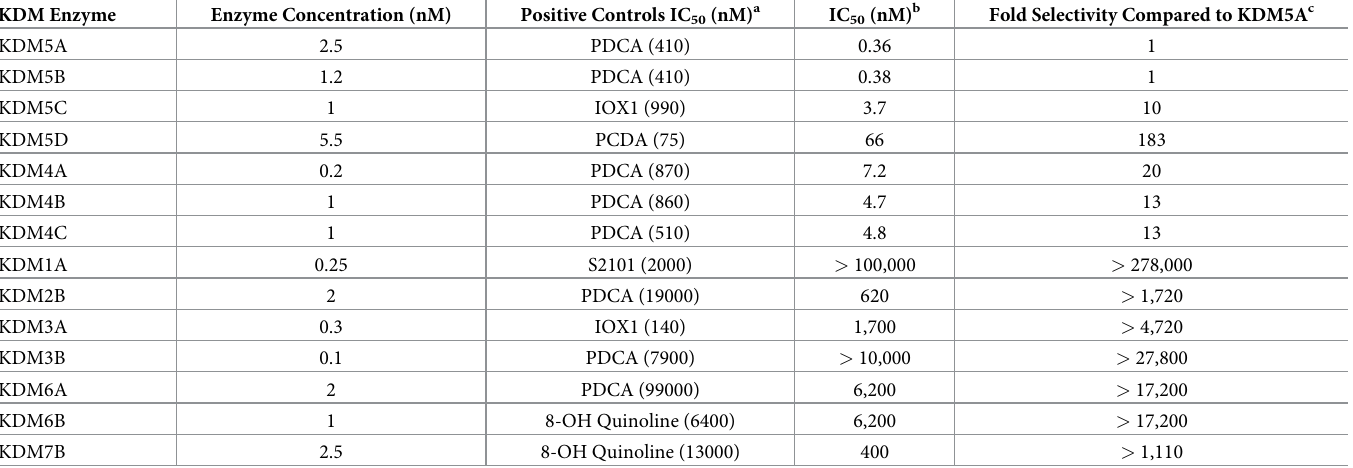
Table 1. Biochemical potency and selectivity of GS-080 against KDM